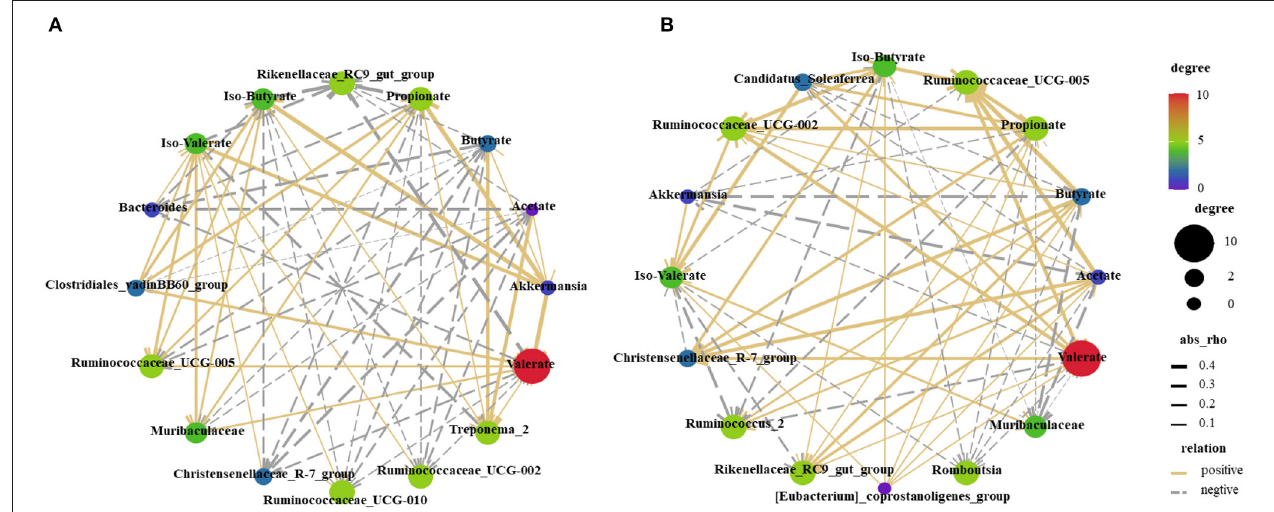
FIGURE 7 | Correlations network analysis between SCFAs and the relative abundance of top 10 predominant bacteria at the genus level in the mucosa (A) and digesta (B) are presented. Silver lines, negative correlation ( P ≤ 0.05); Golden lines, positive correlation ( P ≤